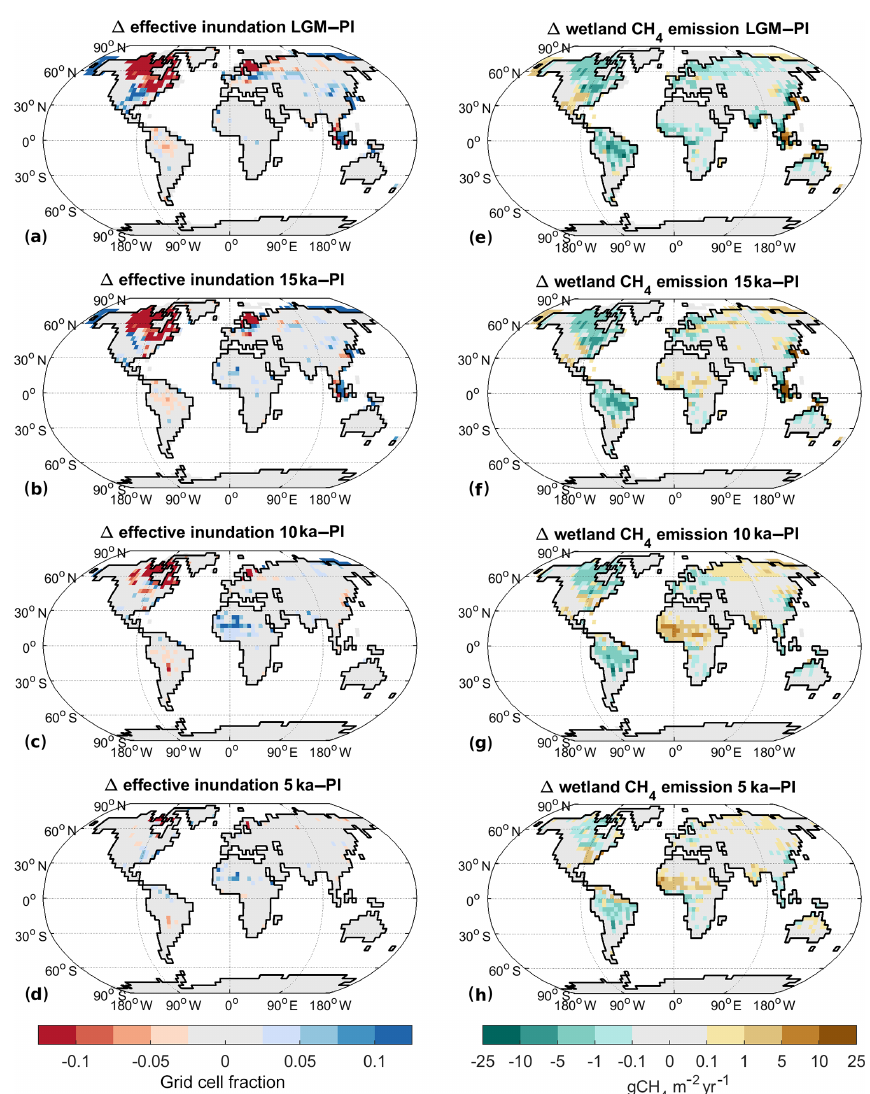
Figure 6. Change in effective inundation and wetland methane emissions for past climate states: (a–d) inundation difference to PI, (e–h) CH 4 emission difference to PI. (a, e) LGM, (b, f) 15ka, (c, g) 10ka, and (d, h)